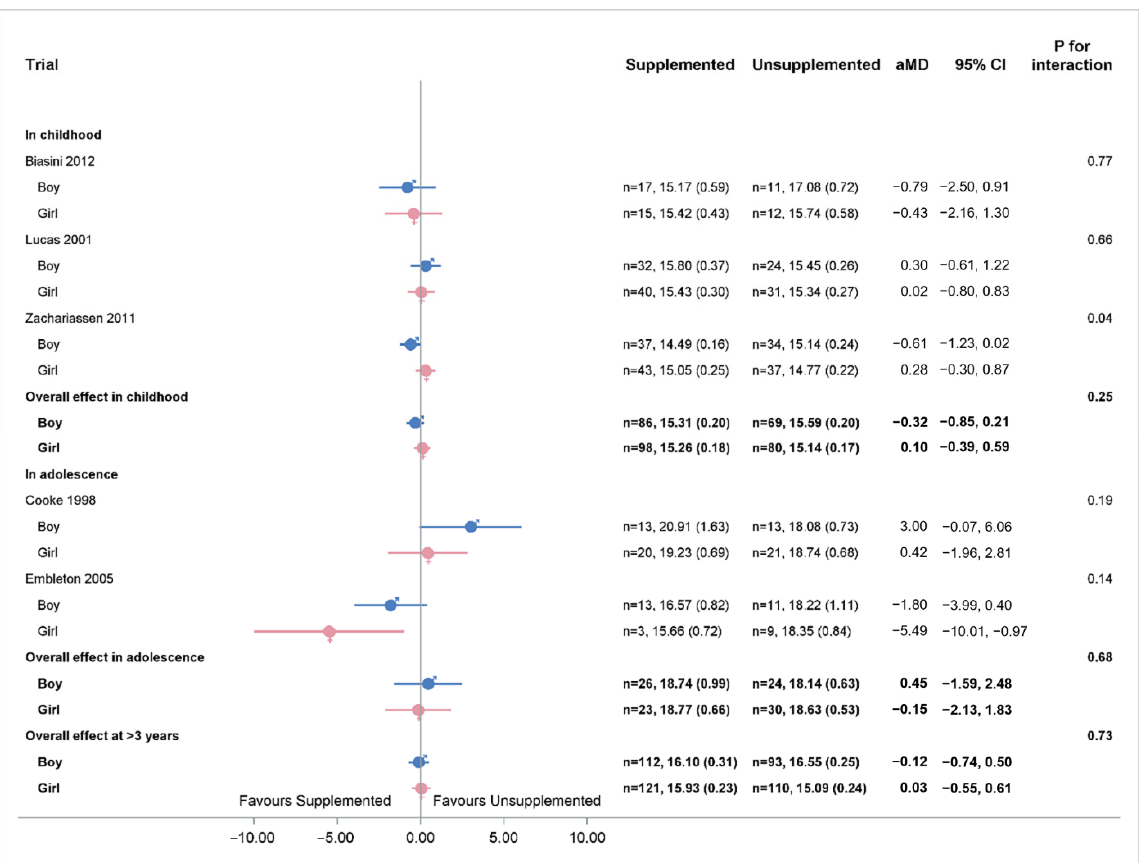
Figure 5 . IPD analysis of BMI separated for boys and girls. p -value for heterogeneity for boys in childhood = 0.17. p -value for heterogeneity for girls in childhood = 0.74. Numbers in bold are overall